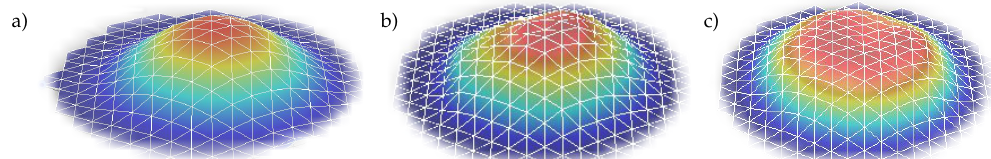
Figure 7. Shape of fundamental mode scanned with a laser Doppler vibrometer. Plates without piston ( a ), with 15µm piston ( b ), and with 25µm piston ( c ) are rastered with high